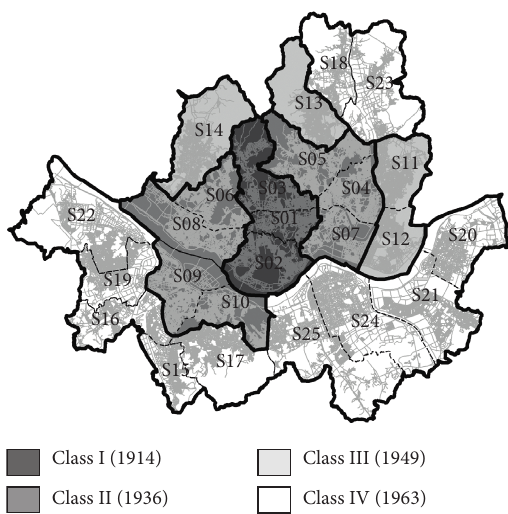
Figure 1: Twenty-five districts in Seoul classified by their devel- opment